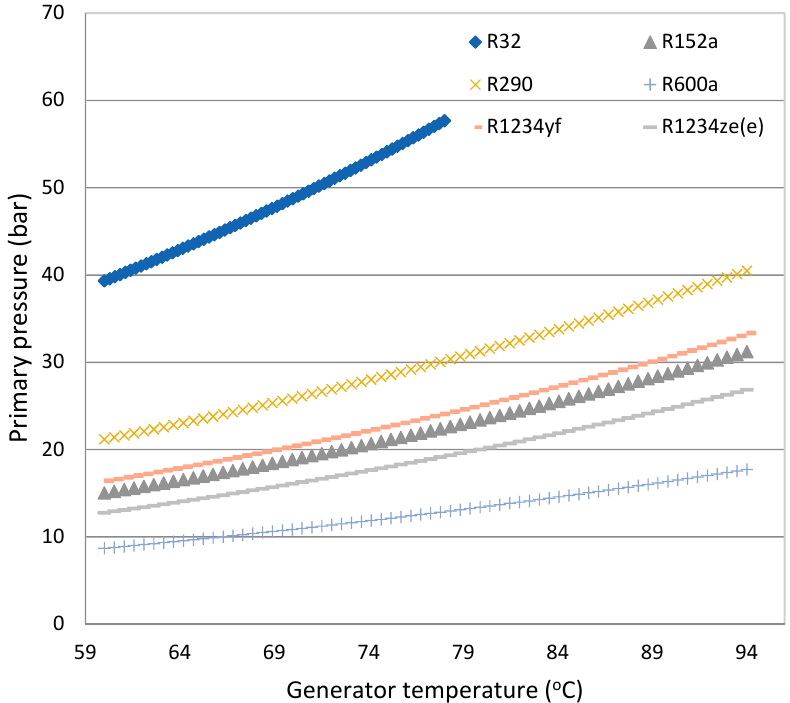
Figure 8. Working pressure of refrigerants at various generator temperatures.